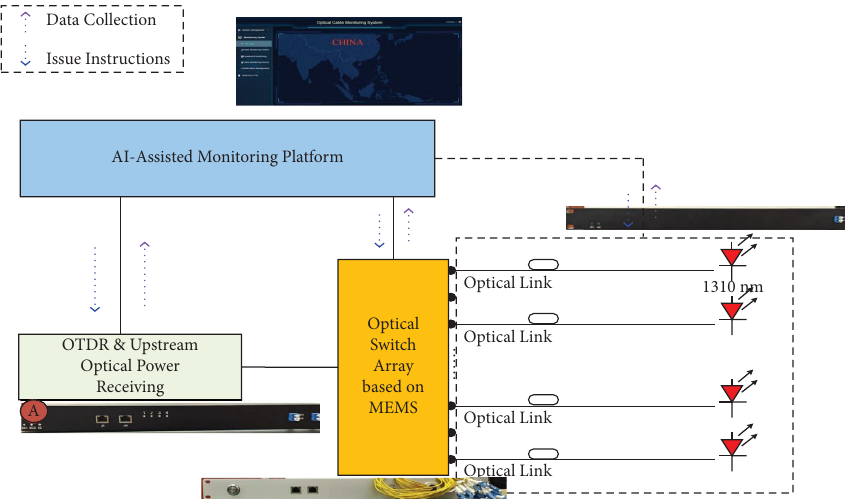
Figure 1: Diagram of AI-assisted failure location